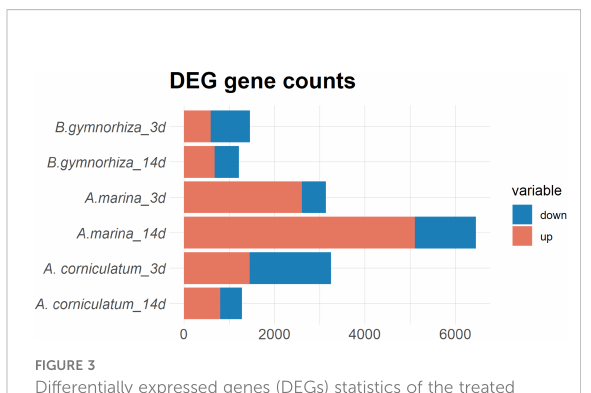
FIGURE 3 Differentially expressed genes (DEGs) statistics of the treated groups (3 and 14 days) compared with the 0-day